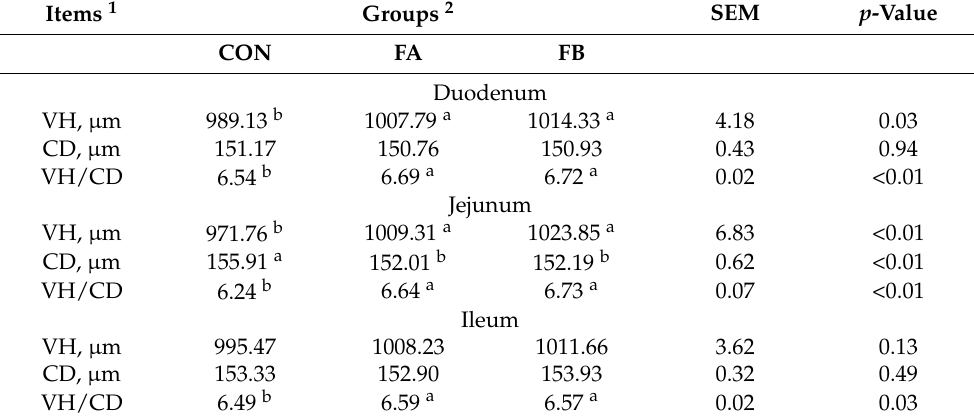
Table 6. Effect of fermented feed on the intestinal morphology of laying hens.